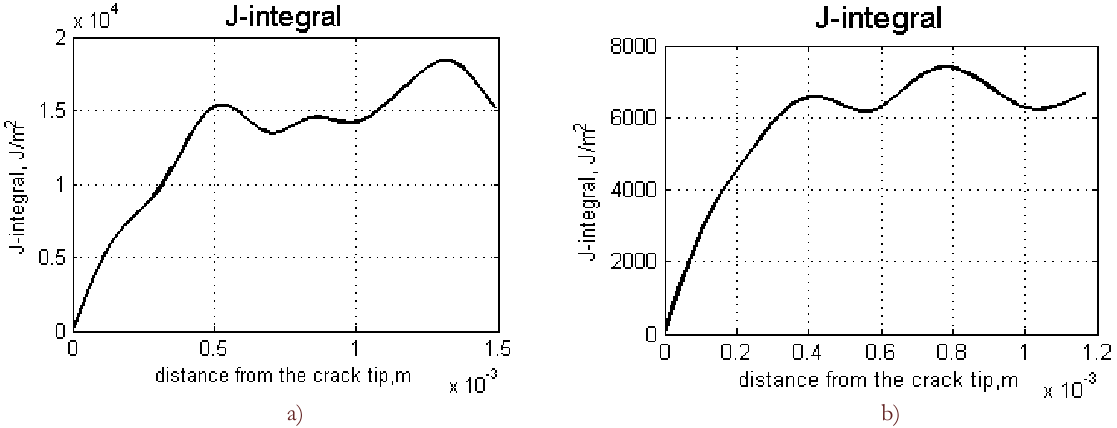
Figure 8: The dependence of J-integral versus a distance from the crack tip in the direction of crack propagation. Loading frequency is 5 Hz (a), loading frequency - 10 Hz (b).